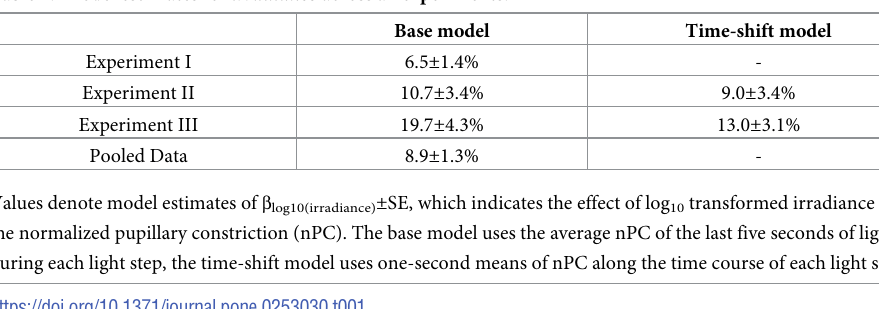
Table 1. Model estimates for irradiance across all